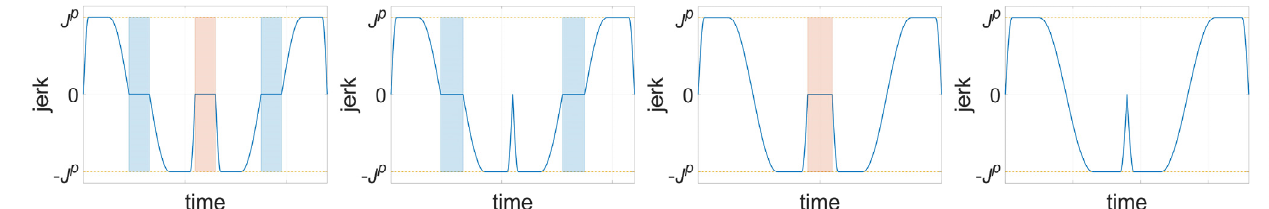
Figure 4. Four types of the locally asymmetrical jerk motion profile.